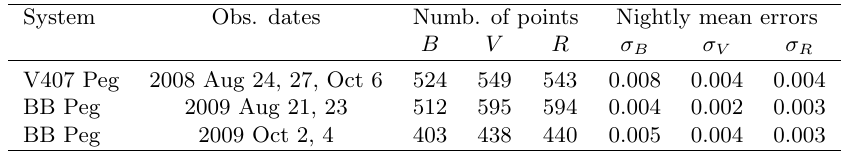
Table 2. Log of the observations.